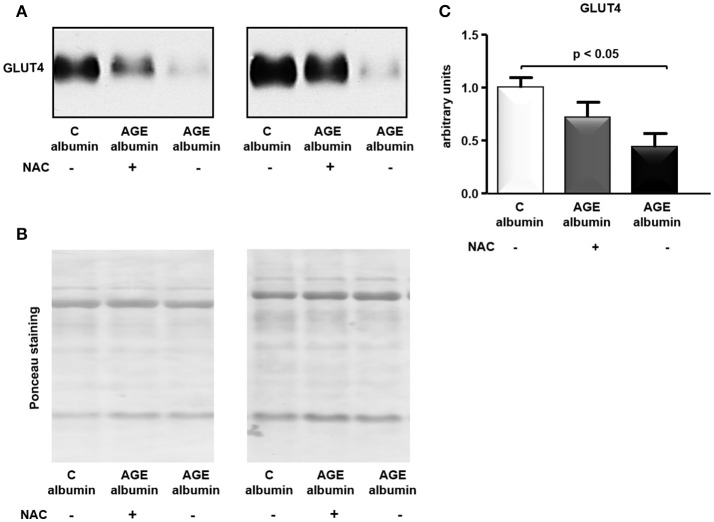
GLUT4 protein level in periepididymal adipose tissue. GLUT4 was determined in adipose tissue from animals treated with C-albumin (n = 4), AGE-albumin (n = 6), and AGE-albumin + NAC (n = 6); equal amounts of cellular protein were applied into a 10% T SDS-polyacrylamide gel and then submitted to immunoblot using rabbit polyclonal antibody against GLUT4 (1:3000; EMD Millipore, Bilerica, MA, USA, #07-1404). The blots were quantified by densitometry (ImageQuant TL, Amersham Biosciences UK Limited) (representative images, A). The Ponceau-stained nitrocellulose membrane was used as loading control (B); after Ponceau normalization results were expressed as arbitrary units considering the mean of the control as 1 in each gel (C).